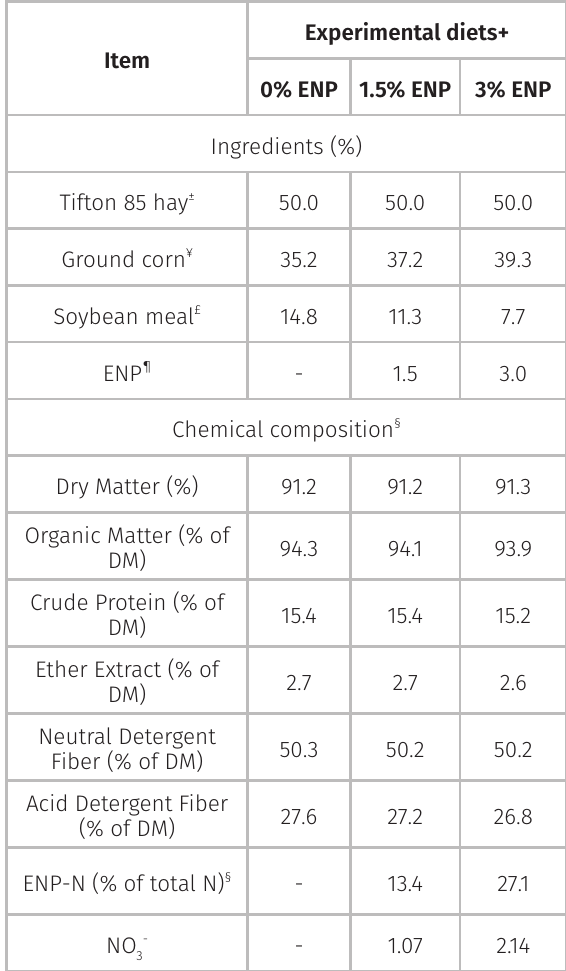
Table I. Ingredients and chemical composition of experimental diets (%, DM basis)